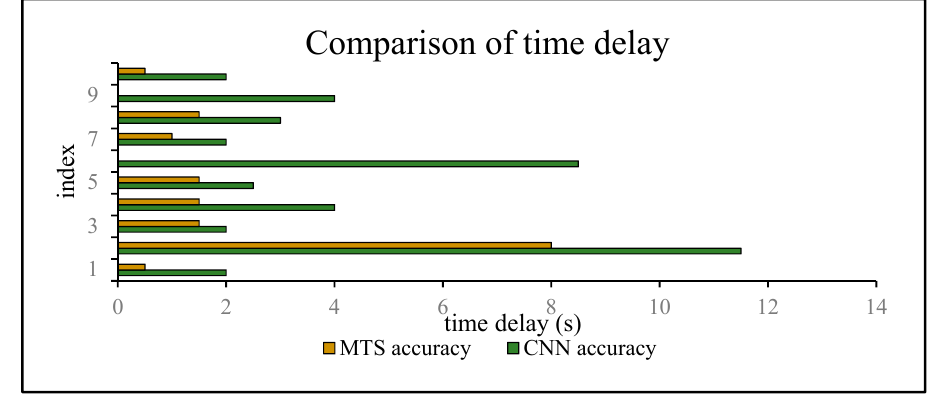
Figure 22. Comparison of the CNN and MTS accuracies with regards to the time delay.